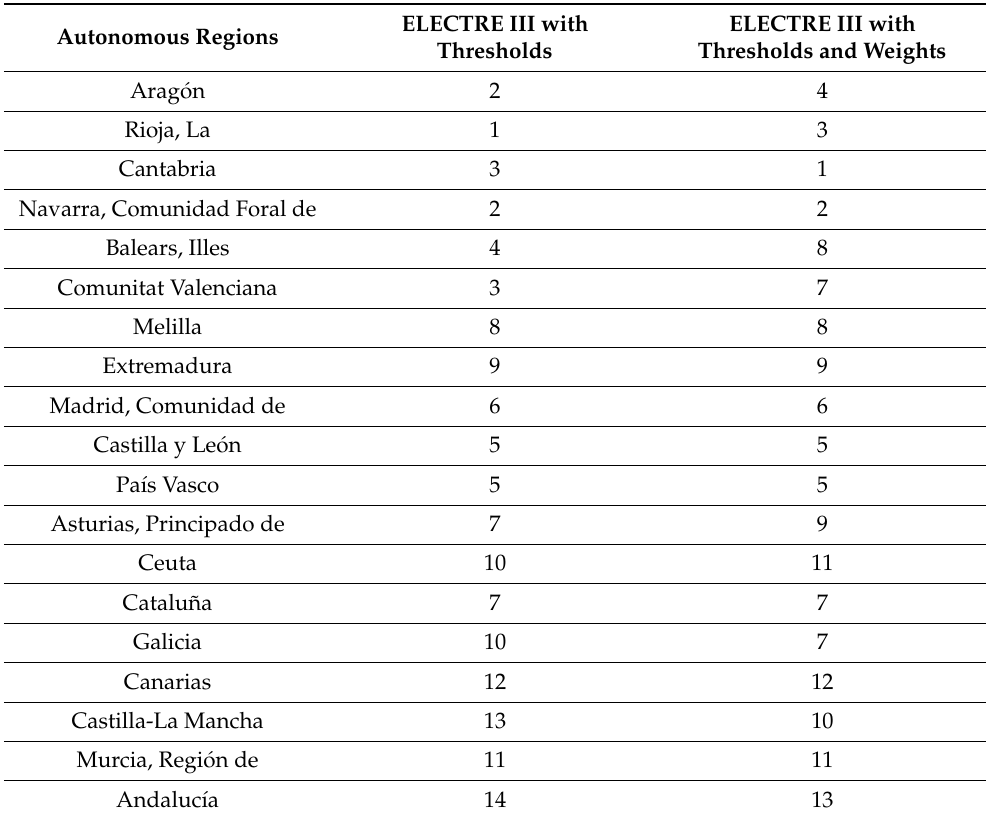
Table 14. Data used to create the Figure